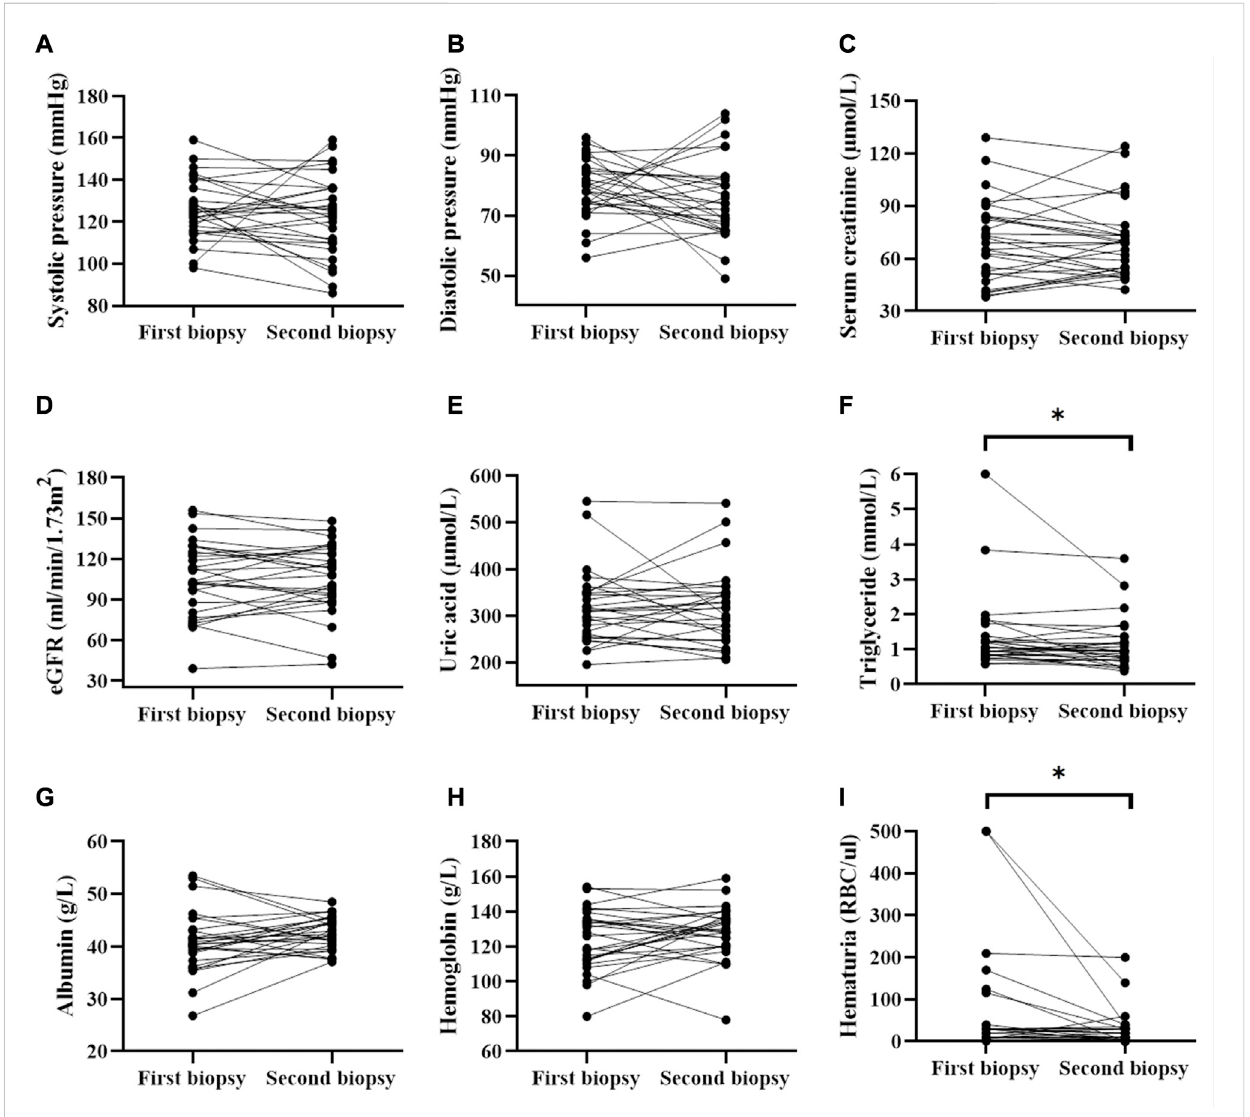
FIGURE 1 Comparison of clinical parameters before and after treatment (data collected from two renal biopsies). * represented that P was less than 0.05.